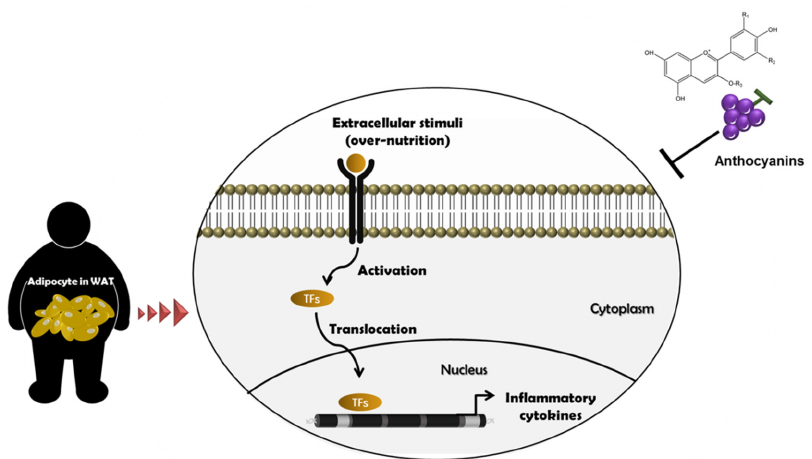
Figure 2. Beneficial effects of anthocyanins on obesity and inflammation. When receptors recognize the status of over-nutrition, they activate various transcription factors such as NF- κ B, IRF-3 and AP-1 for translocation into nucleus and bind to the promoter region of target genes. Eventually, inflammatory cytokines are expressed resulting in chronic inflammatory conditions in adipocytes of WAT. Dietary anthocyanins may have preventive effects on these events, leading to health